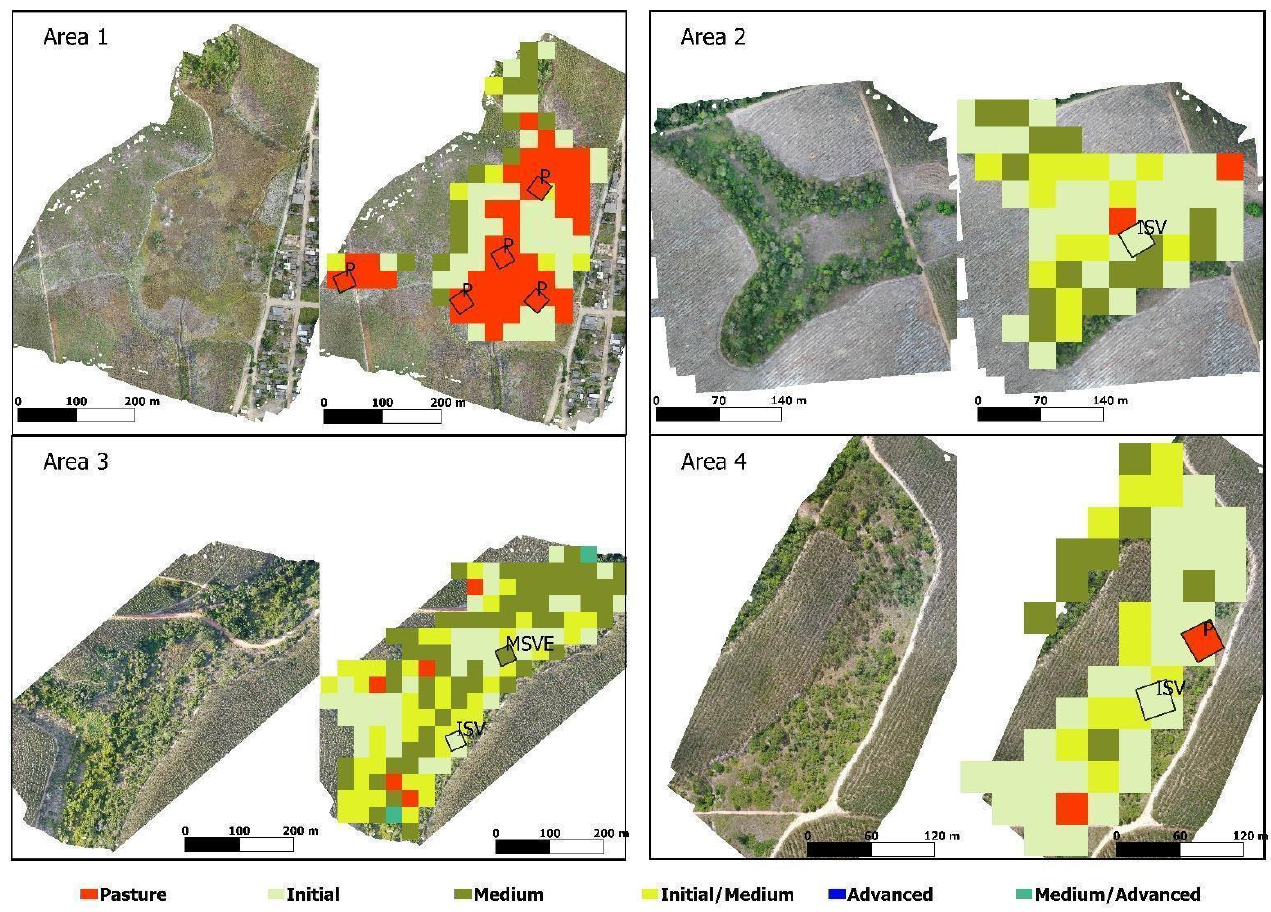
Figure 13. Spatialization of the succession stage estimation for areas 1 to 4 based on DAP-UAV point clouds.